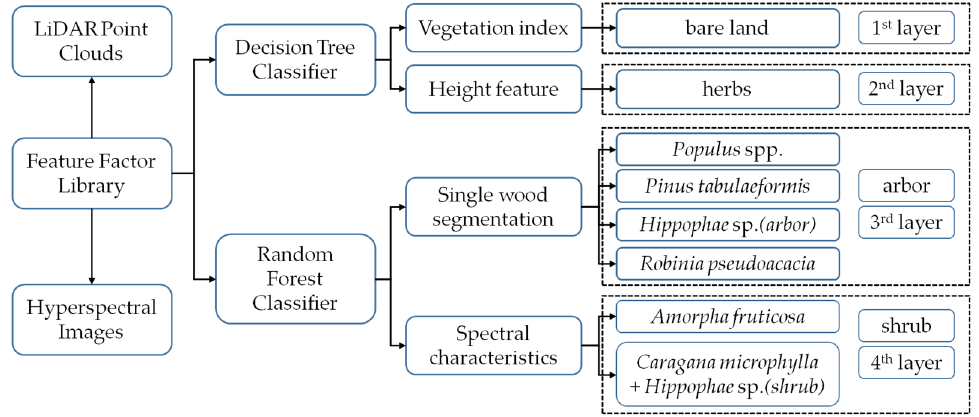
Figure 2. Hierarchical classification flow chart of vegetation species composition.